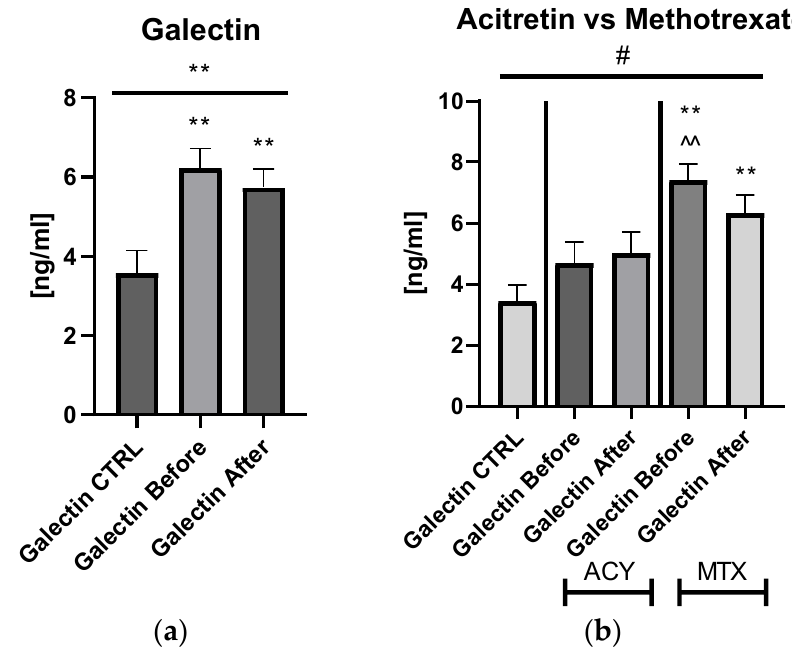
Figure 1. The levels of gal ‐ 3 in psoriatics before and after total treatment ( a ) compared to control